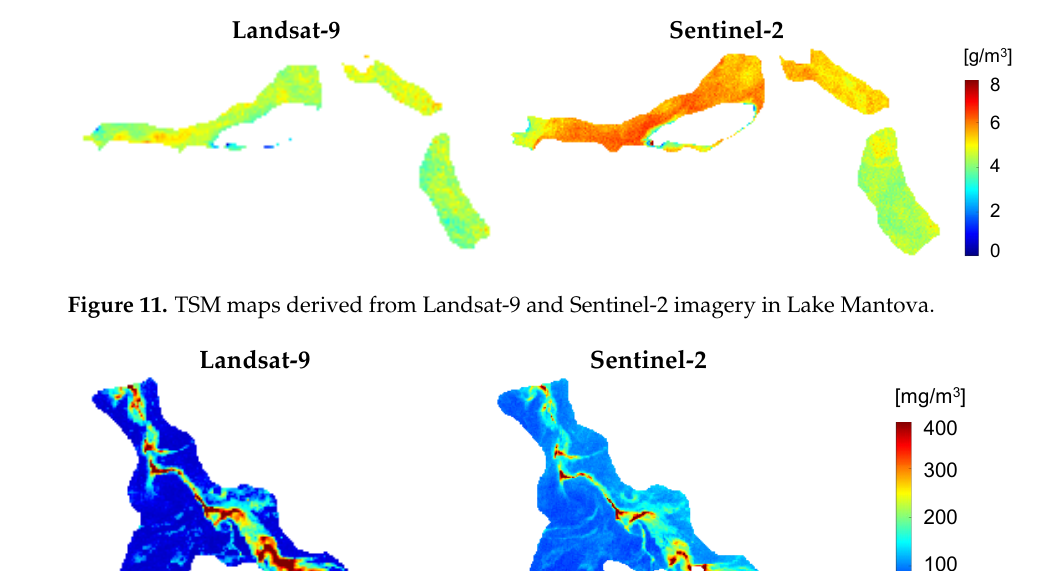
Figure 10. TSM and Chl-a maps derived from Landsat-9 and Sentinel-2 imagery in Lake Maggiore.